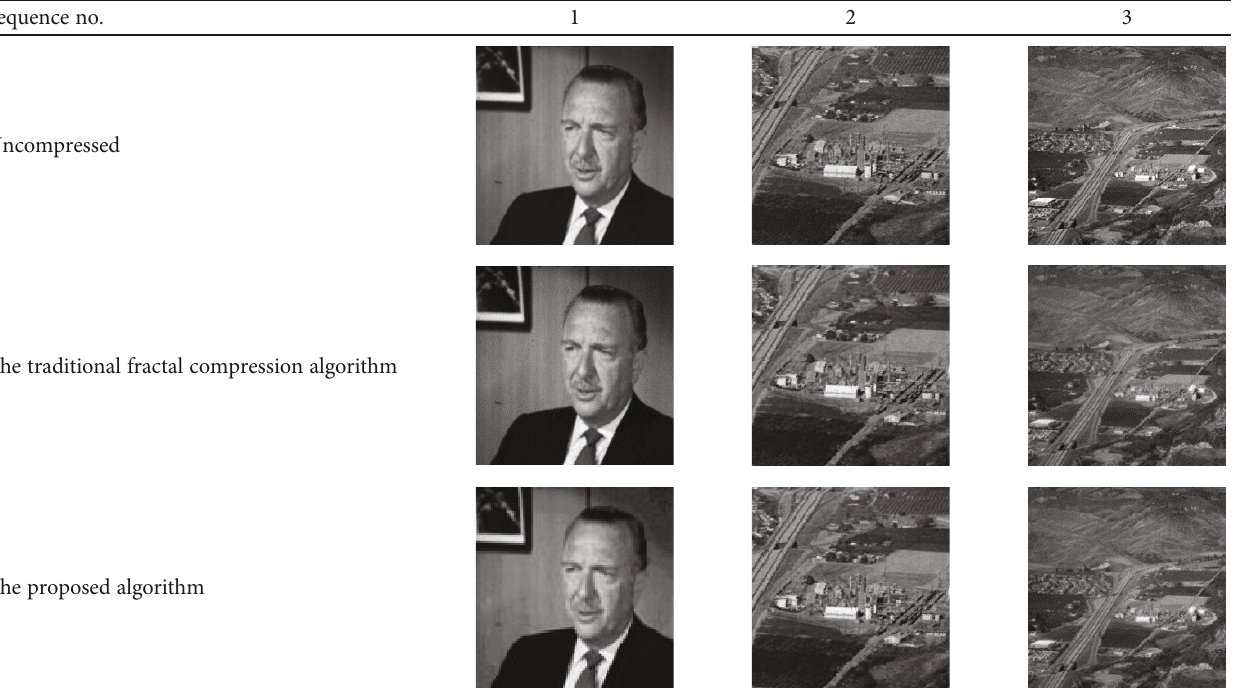
Table 2: Comparison of decoding e ff ects between traditional algorithm and proposed algorithm. Sequence no.